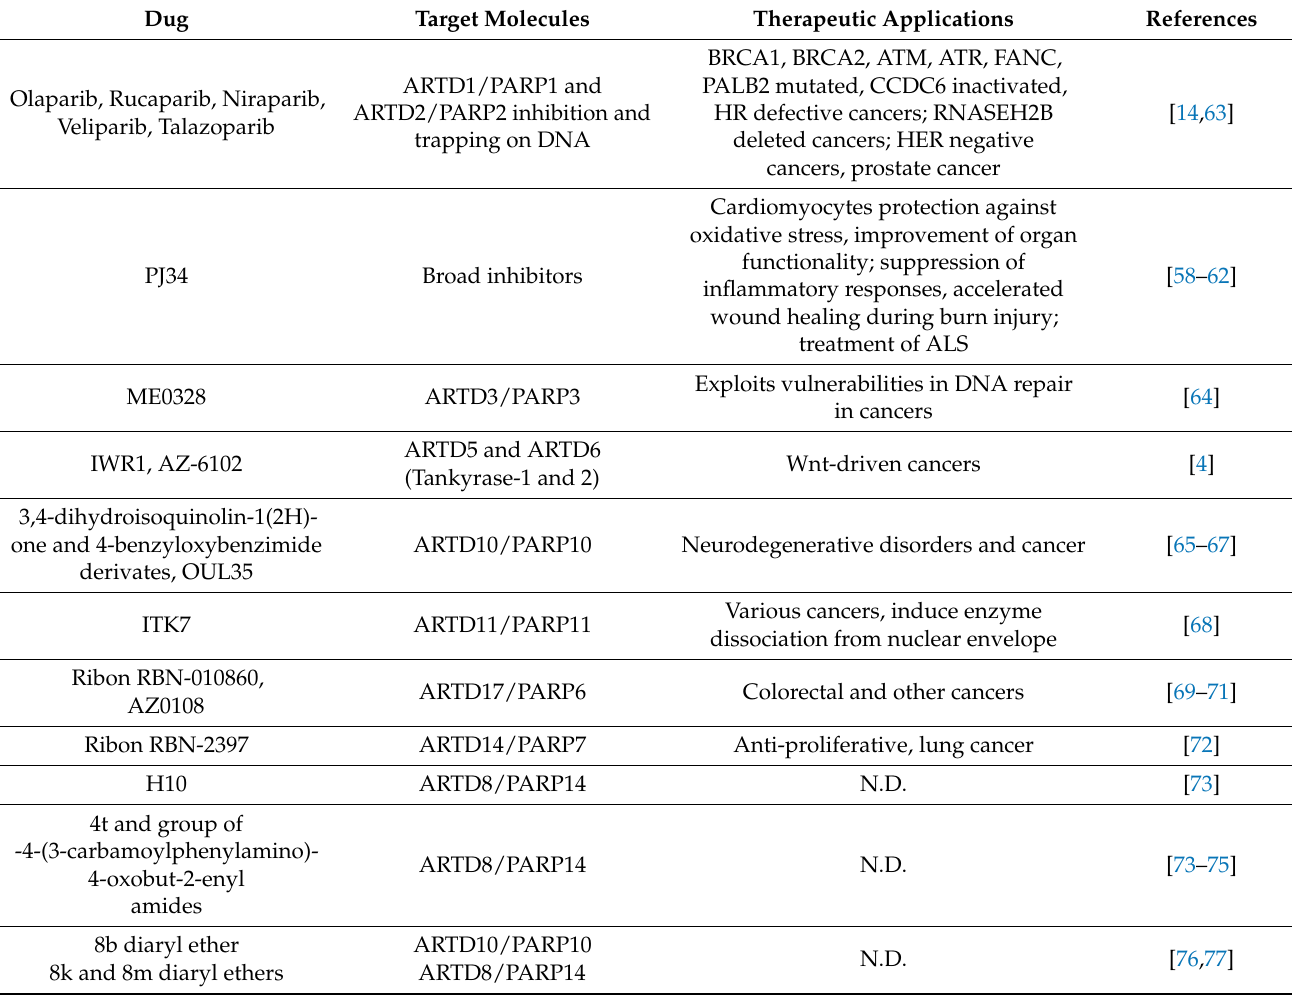
Table 1. Selective inhibitors of ADP-ribosyl transferases (ARTs) and therapeutic potential.